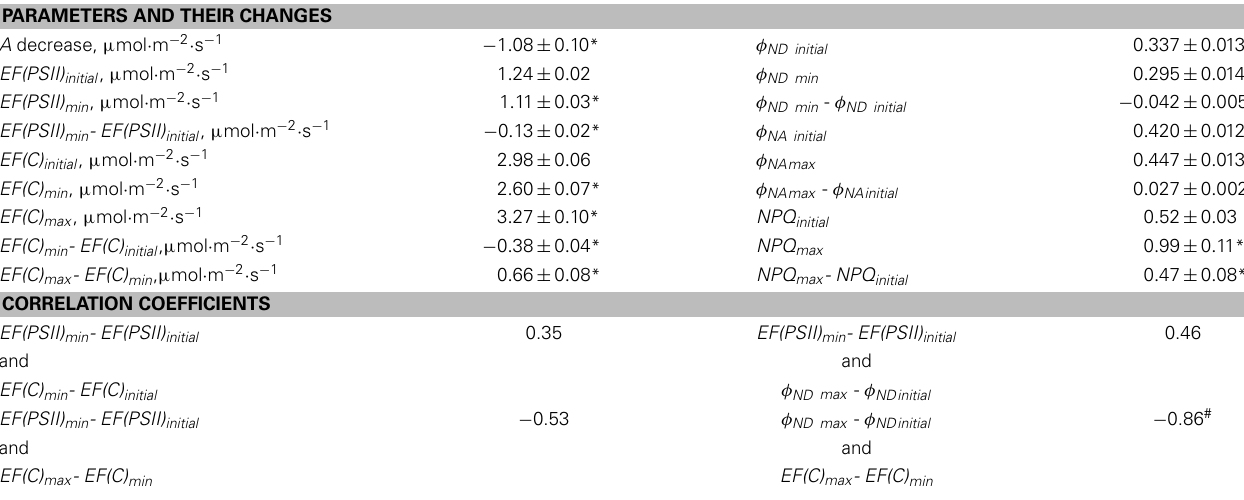
Table 3 | Photosynthetic parameters and changes induced by VP and correlation coefficients under far red light conditions. PARAMETERS AND THEIR CHANGES